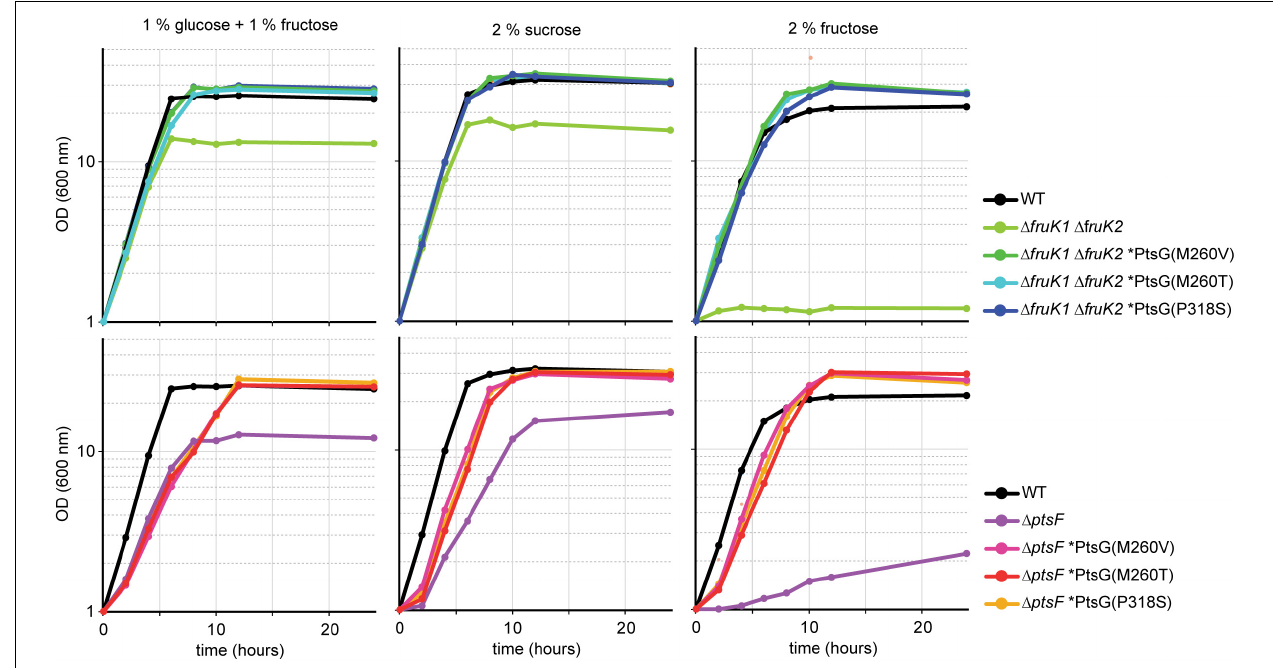
FIGURE 3 | Growth of isolated fructose mutants on glucose + fructose, sucrose, and fructose. Data represent one of two individual cultivations that differed <